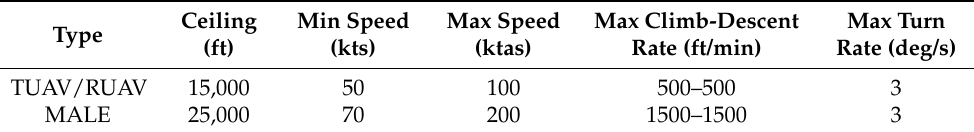
Table 1. RPAS performance range used for the WCV